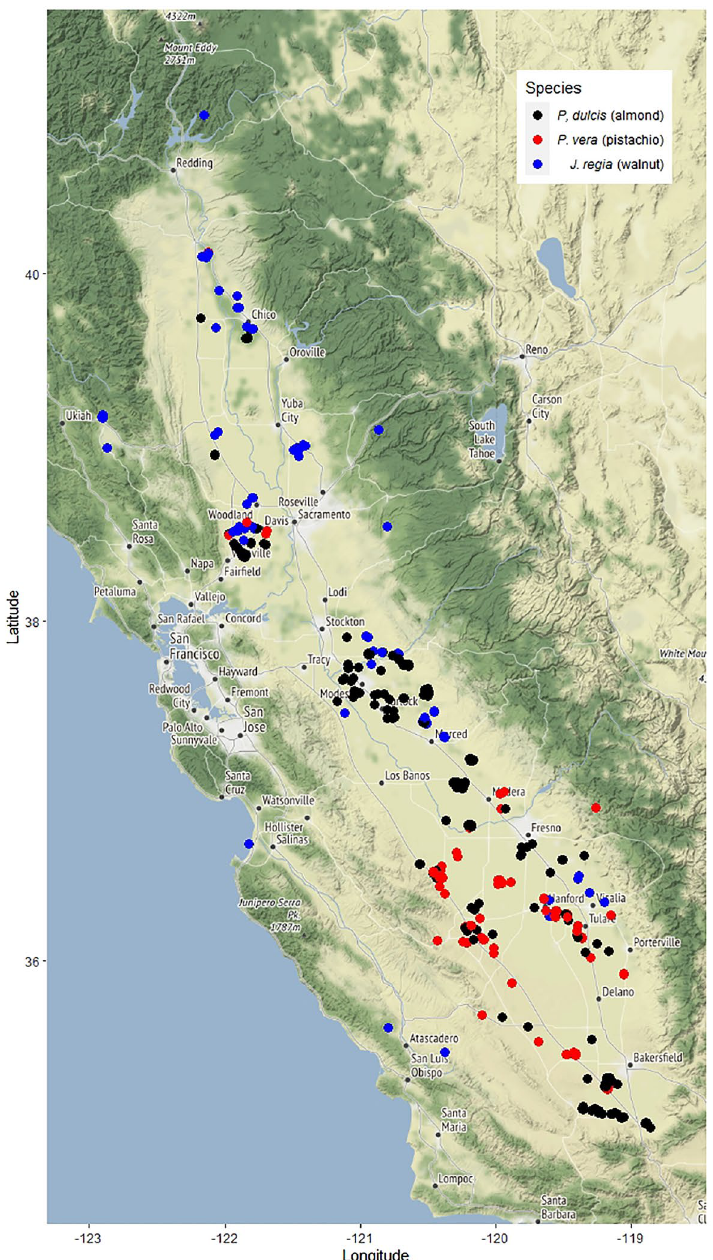
Figure 1. Map of the Central Valley of California depicting the locations of participating orchards of three species ( P. dulcis, J. regia, and P. vera ). Each point may represent multiple sites that are close in latitude and longitude (R version 3.6.3 package “ggplot2” 25 ).